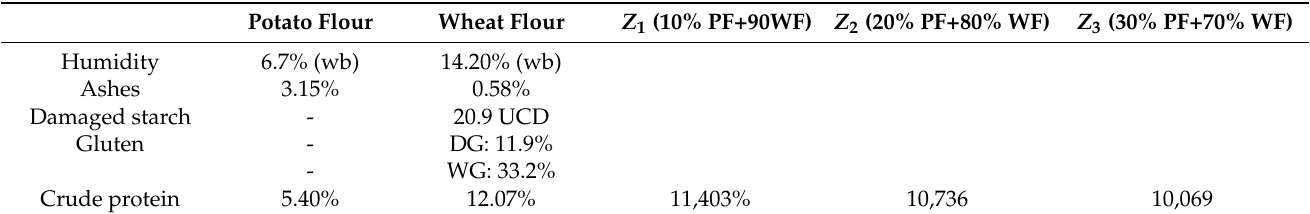
Table 1. Flour quality and protein analysis of samples Z 1 , Z 2 and Z 3